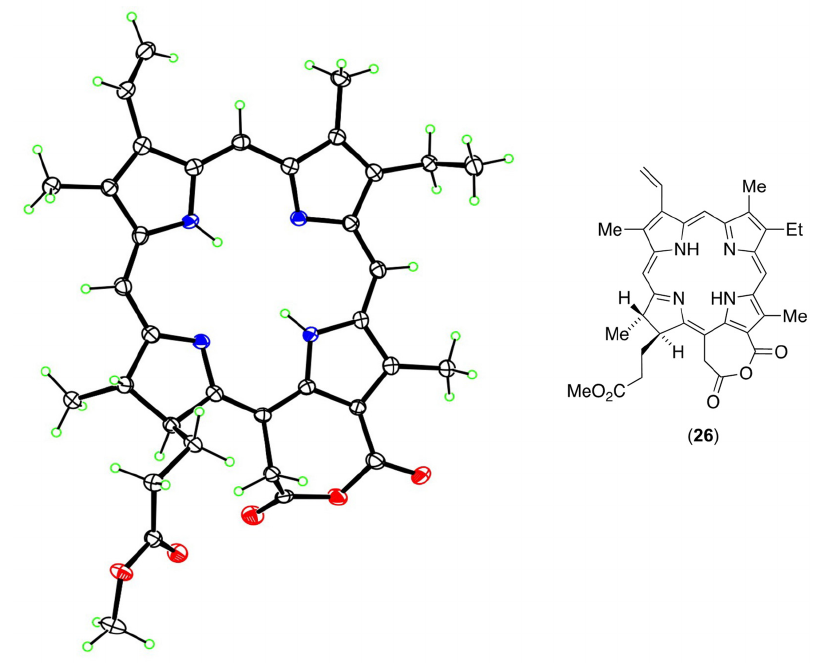
Figure 7. X-ray structure of anhydride methyl ester ( 26 ).